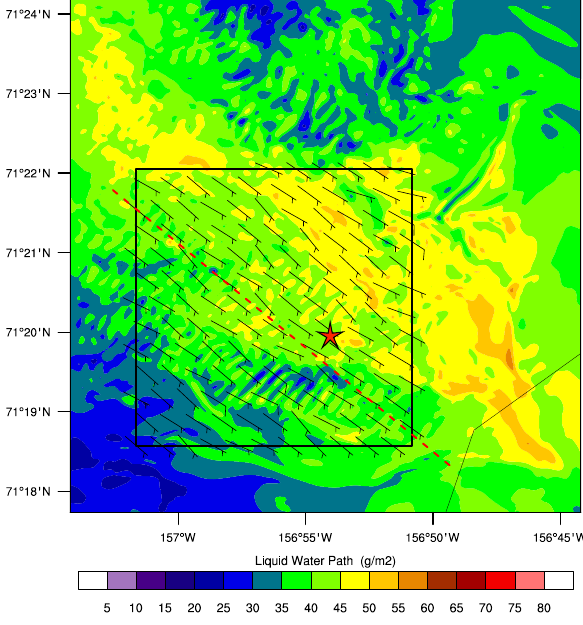
Fig. 6. Liquid water path (color) and winds (flags) at maximum liquid water level at 20Z on 8 April 2008 for the 50m nest. A half barb on the wind flags indicates 5ms − 1 and a full barb 10ms − 1 . The square marks the region used to make total, downdraft, and updraft averages (130 × 130 grid points). The red star marks the location of vertical profiles plotted in Fig. 2 and the 50m spectra in Fig. 5. The red dashed line marks the diagonal slice plotted in Fig. 7. Barrow, Alaska is located directly to the east of the red star, to the right of thin black lines in the lower right marking the Alaska